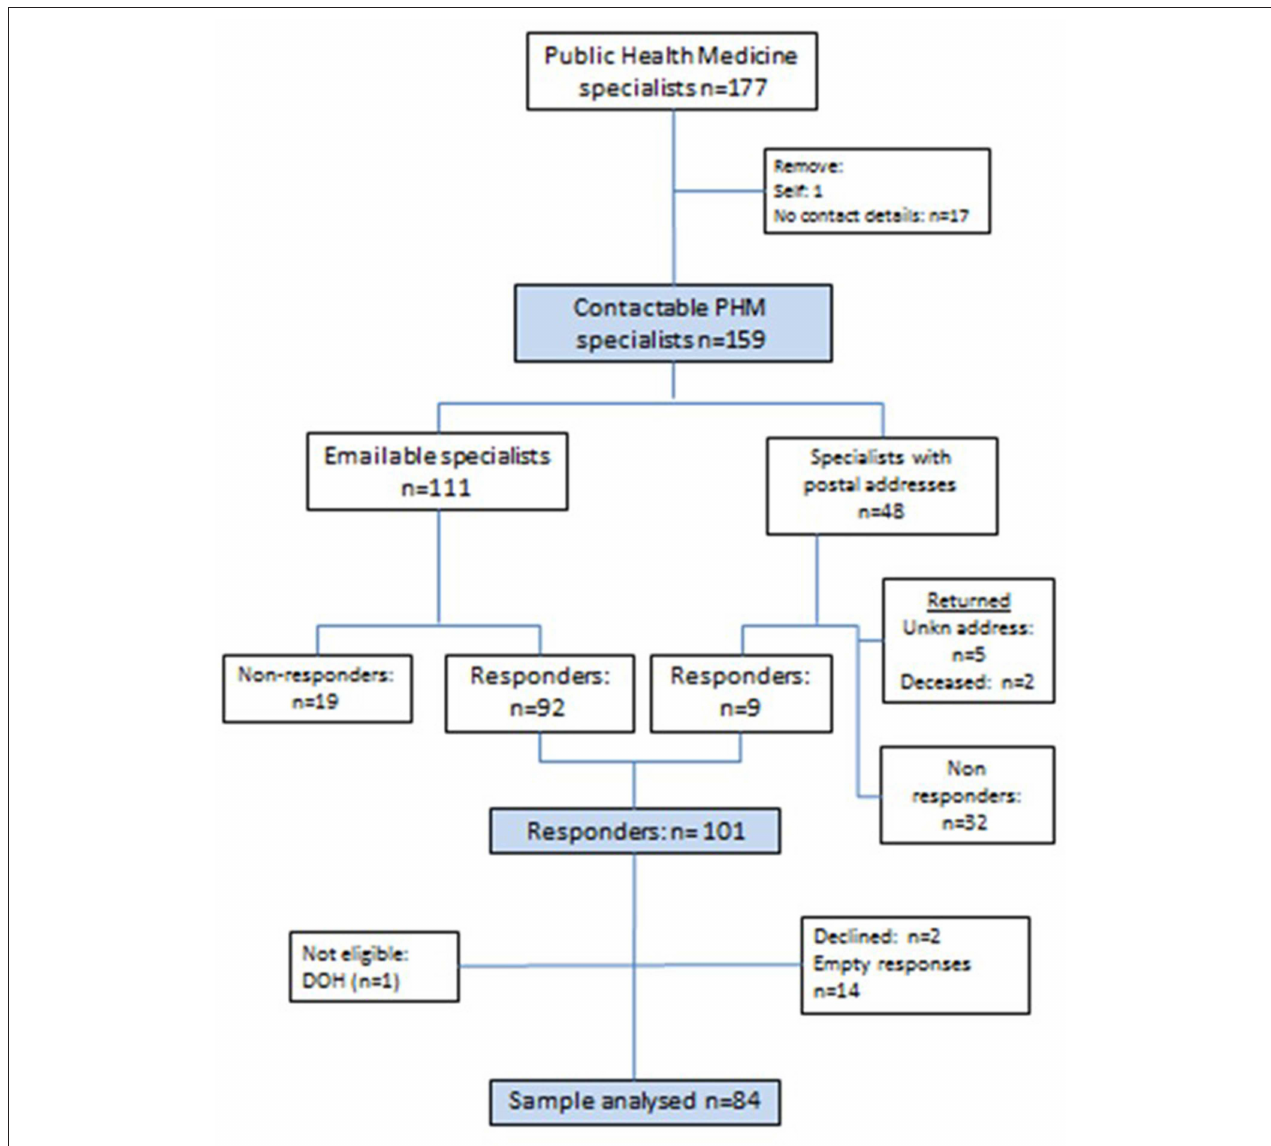
FIGURE 1 | Flow diagram describing eligibility and